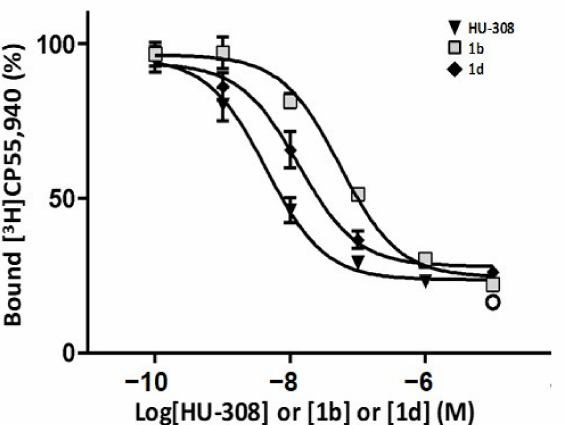
Figure 4. In vitro interaction of the agonists HU-308 , 1b and 1d with hCB2R. Ki values for CB2R were derived from displacement of [ 3 H]CP-55,940 binding in membranes of CHO-K1 cells expressing human CB2R. Each curve represents the mean of three experiments performed in